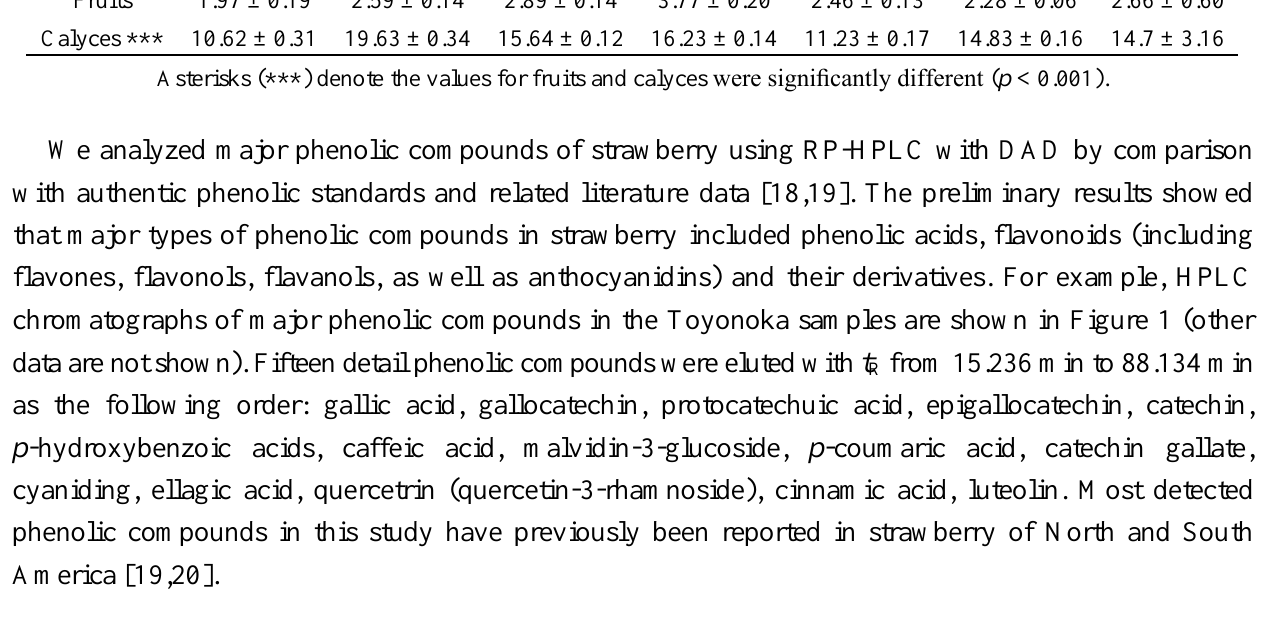
Figure 1. HPLC profiles of Toyonoka strawberries. Peaks: 1: gallic acid; 2: